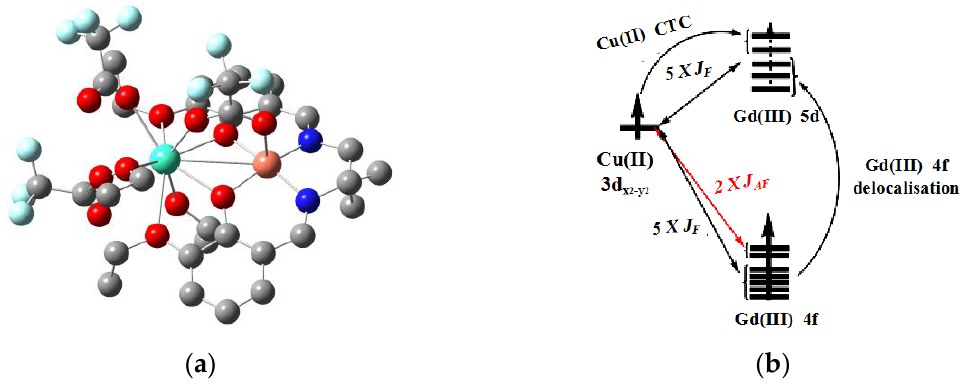
Figure 10. ( a ) Crystal structure of [LCuGd(O 2 CCF 3 ) 3 (C 2 H 5 OH) 2 ]. Cu, orange; Gd, dark cyan; C, gray; N, blue; O, red; F, light cyan. All hydrogen atoms are omitted for clarity. ( b ) Mechanism diagram of magnetic exchange at Cu(II) and Gd(III) sites. The 5 d orbitals of Gd(III) accept charge densities from its 4 f orbitals and 3 d orbitals of Cu(II) (adapted with permission from [60]). Zhang’s group carried out a detailed study on a group of cyano-bridged compounds with first and second transition metal magnetic centers using the DFT-BS method [61]. Four model complexes marked A, B, C and D, whose structures are from synthesized